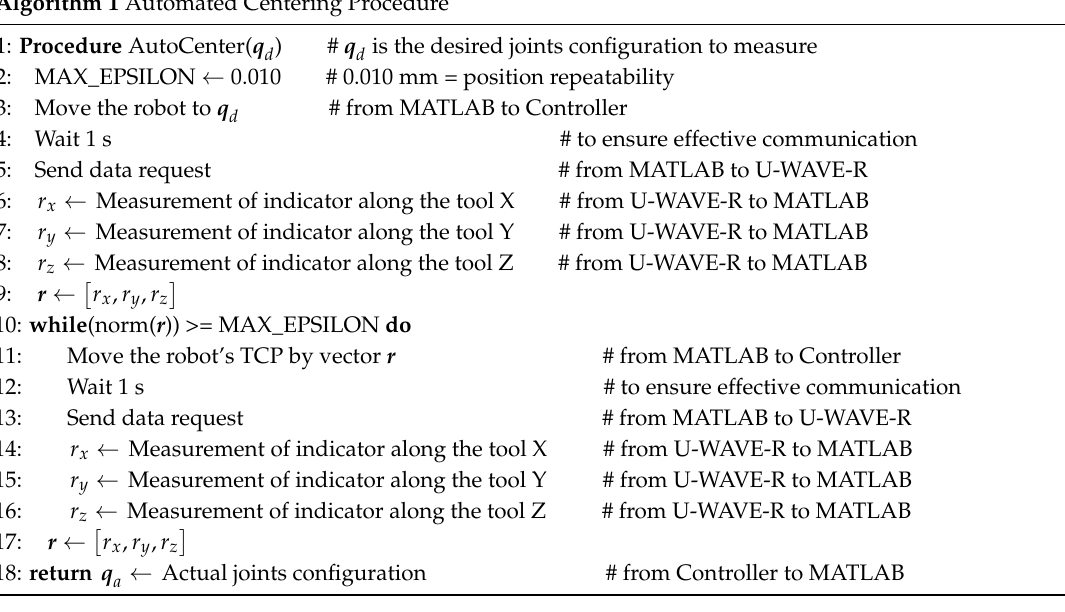
Algorithm 1 Automated Centering